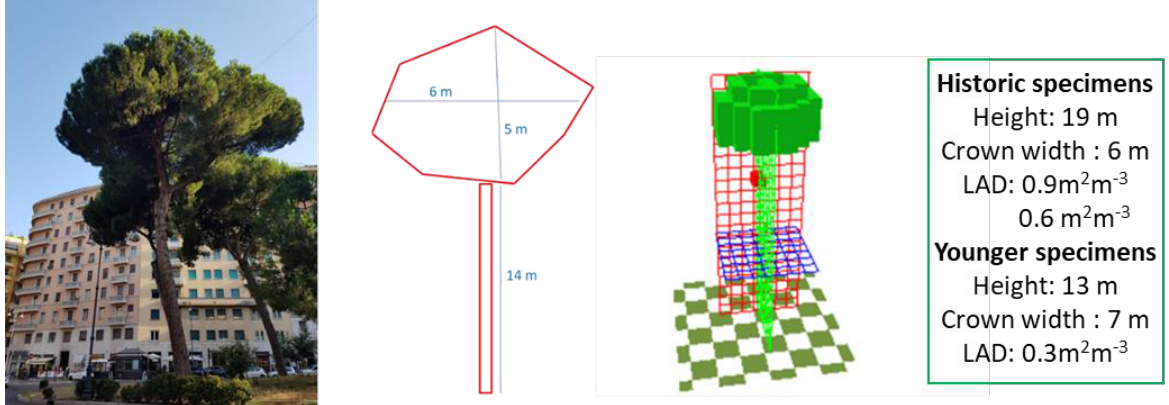
Figure 8. Example of steps followed for the creation of a 3D model of Pinus pinea L. with the ENVI-met Albero tool. Left : Photographic survey; middle : Measurement and plant geometry simplification; right : Three-dimensional model of Pinus pinea L. In the green box the characteristics of historical and younger specimens are reported.